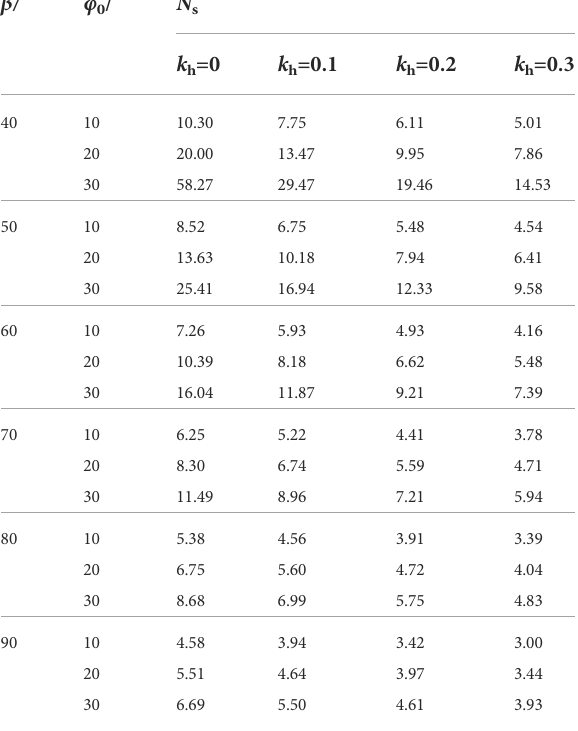
TABLE 3 Stability factor with different slope angles ( b =0.5, ζ =0.5). TABLE 4 Stability factor with different k h ( ζ =0.5, β =70 °